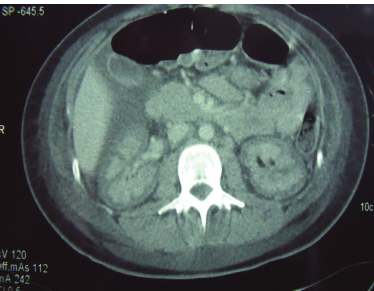
Figure 2: Renal biopsy viewed at low power stained with Trichrome Stain. There is severe fibrosis with subcapsular and cortical